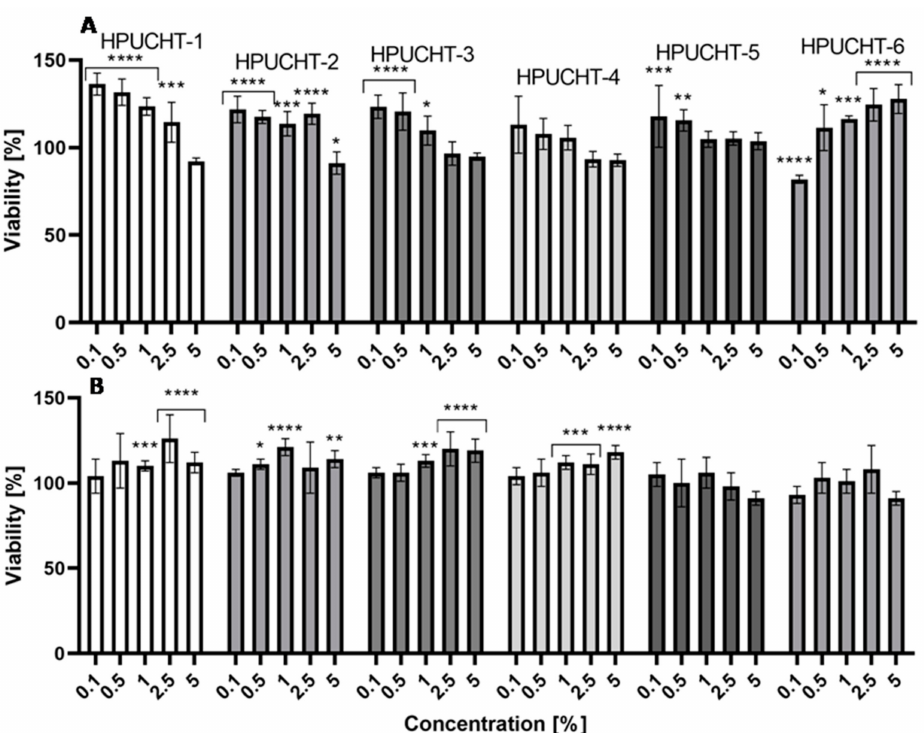
Figure 6. Thereduction of resazurin after 2 h ( A ) and 24 h ( B ) of exposure to extracts (0.1–5%) from hydrogels in cultured HaCaT cells. **** p ≤ 0.0001, *** p ≤ 0.001, ** p ≤ 0.01, * p ≤ 0.05 versus the control